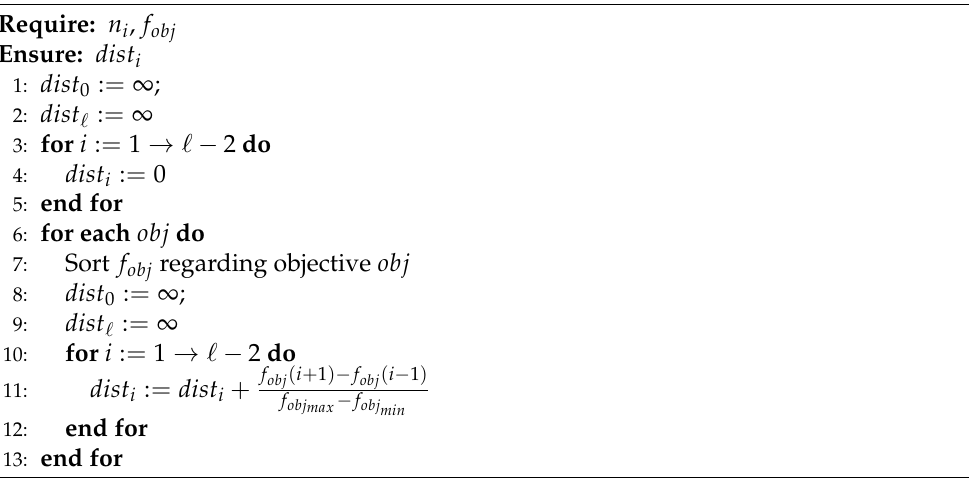
Algorithm 3 Crowding distance